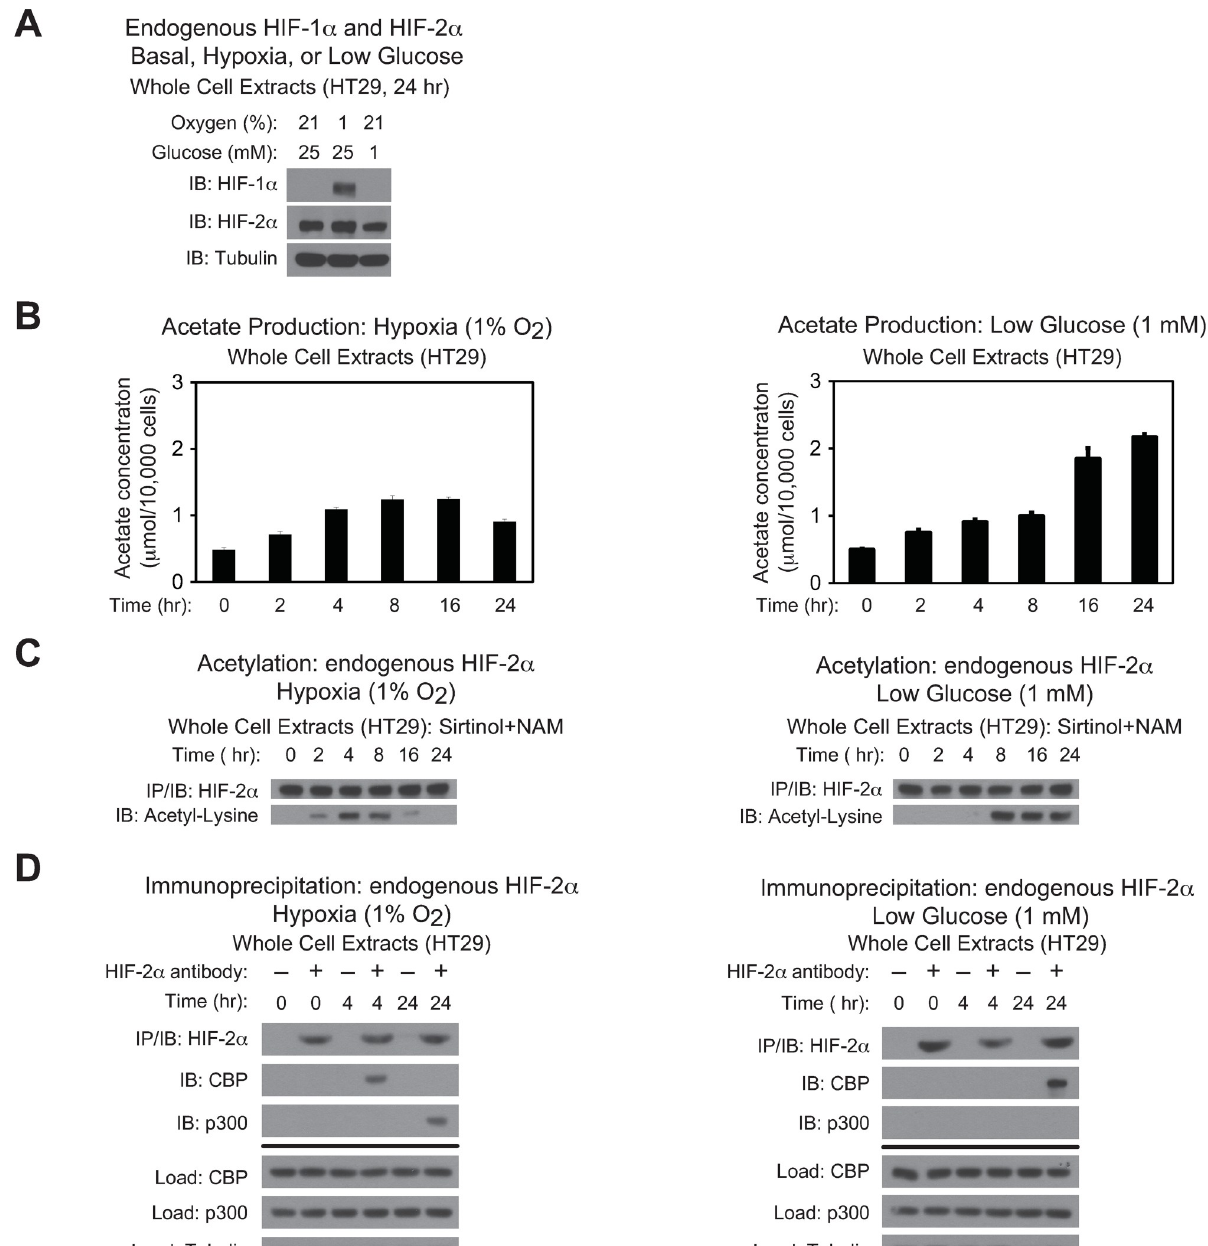
Fig 2. Stress induces CBP/HIF-2 α interactions in HT29 cells. (A) Detection of endogenous HIF-1 α or HIF-2 α in HT-29 whole cell extracts by immunoblotting after the indicated period of hypoxia exposure or glucose deprivation. Alpha-tubulin levels for each immunoblot are also shown. (B) Cellular acetate levels generated in HT29 cells after the indicated period of hypoxia exposure (left side) or glucose deprivation (right side) ( n = 3 biological replicates/time-point; single measurement/replicate; mean/SD) differed as a function of time (P < 0.001, one-way ANOVA). (C) Acetylation of endogenous HIF-2 α in HT29 cells after immunoprecipitation (IP) and detection by immunoblotting (IB) after the indicated period of hypoxia exposure (left side) or glucose deprivation (right side) with pharmacological inhibition of Sirt1 by sirtinol and nicotinamide (NAM). (D) Detection of endogenous CBP/HIF-2 α or p300/HIF-2 α complexes in HT29 cells by immunoblotting (IB) after early (4 hr) and late (16 hr) hypoxia exposure (left side), or after early (2 hr) and late (24 hr) low glucose exposure (right side).